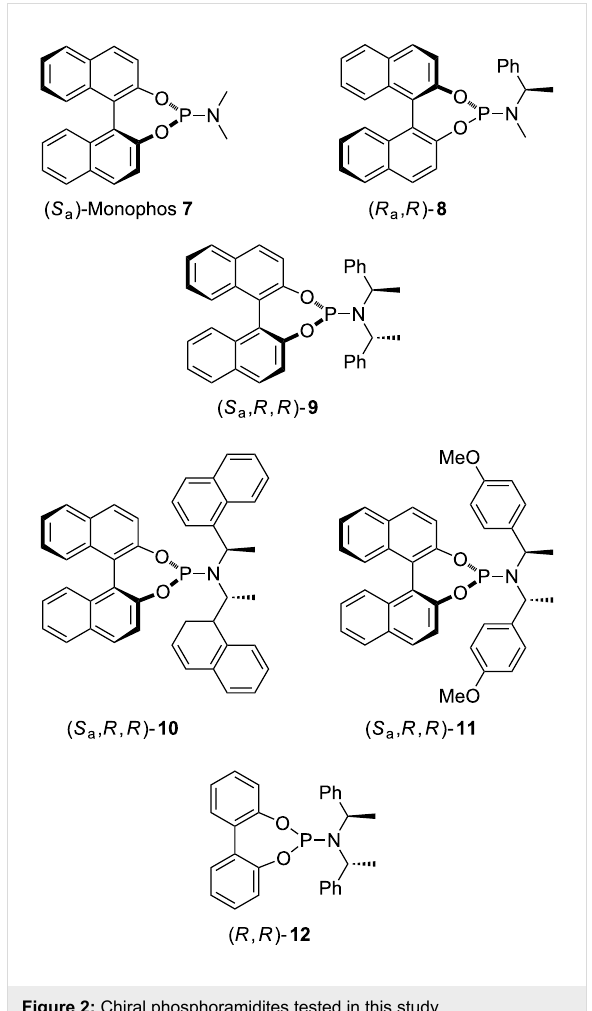
Figure 2: Chiral phosphoramidites tested in this